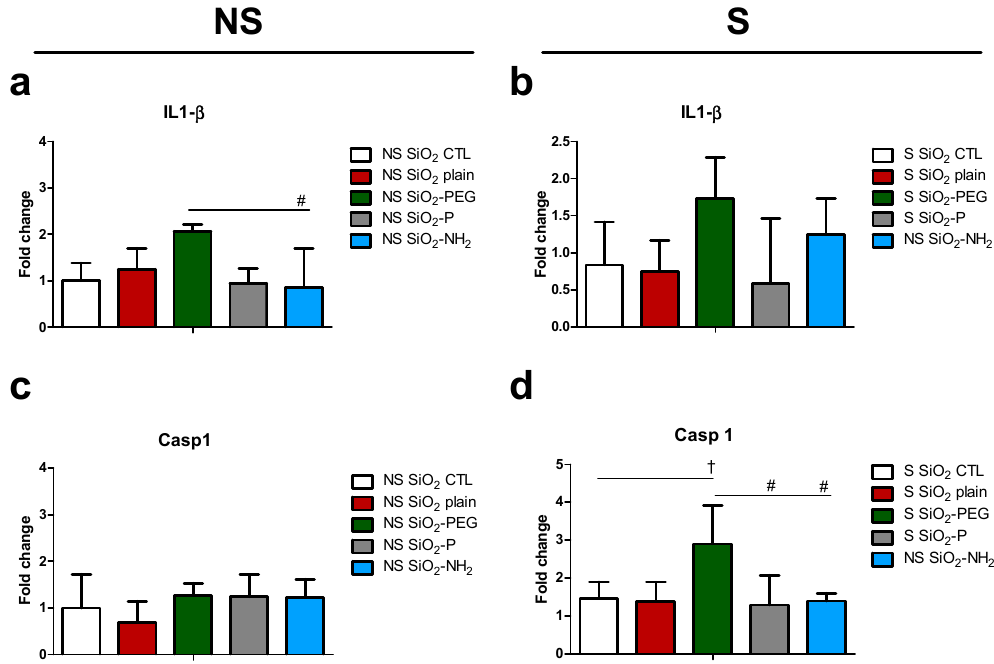
Figure 4. Effect of SiO 2 NPs on inflammasome activation in vivo . IL-1 β and Casp1 gene regulation in lungs of NS ( a , c ) and S mice ( b , d ) 5 days after intratracheal instillation of 50 µ g SiO 2 plain (red), SiO 2 -PEG (green), SiO 2 -P (gray) or SiO 2 -NH 2 blue) or supernatant control (CTL) and ovalbumin challenge. Mean ± standard deviation were evaluated in the lung by real-time PCR ( n = 4/group). One-way Anova † p < 0.05; vs. CTL. # p < 0.05; vs. SiO 2 -PEG ( n = 4).